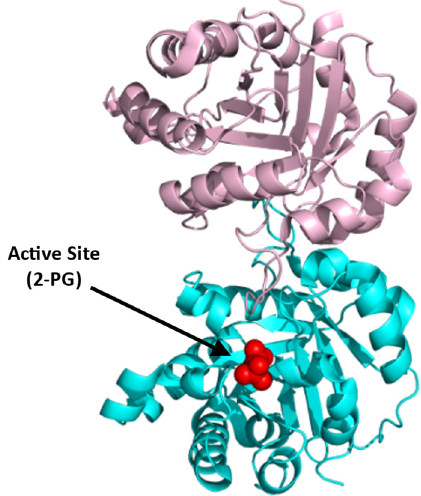
Figure 11. Crystal structure of TPI (PDB:1HTI), showing the active site with bound 2-PG (red sphere). The two subunits are shown in ribbons and colored pink and cyan.